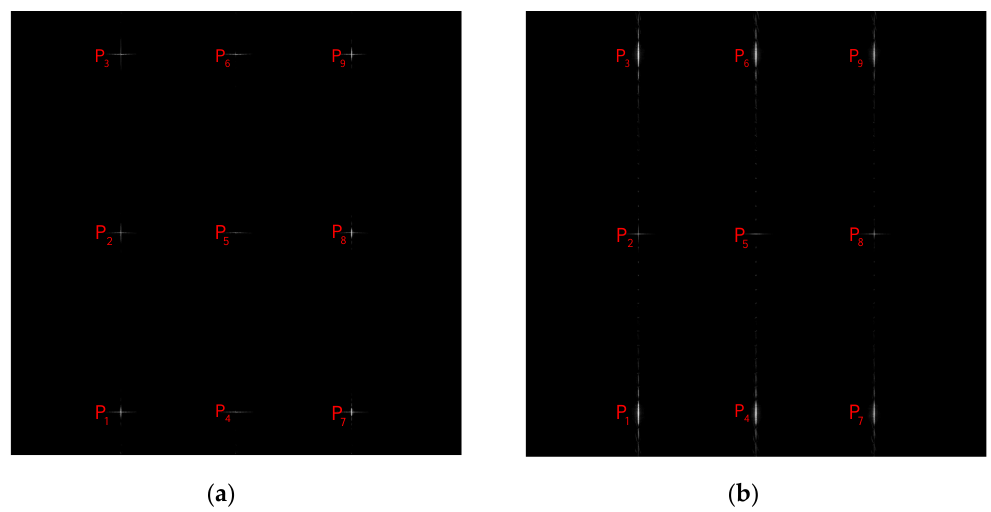
Figure 9. Image results obtained by using ( a ) HSHD-AFBP and ( b ) HS-AFBP.